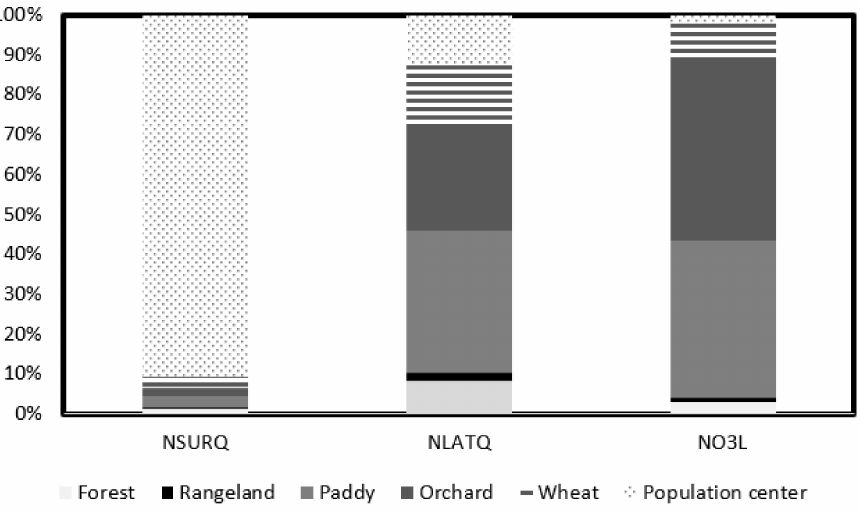
Figure 9. Various components related to nitrogen losses. NSURQ: NO 3 contributed by HRU in surface runoff to reach (kg N/ha), NLATQ: NO 3 contributed by hydrologic response unit (HRU) in lateral flow to the adjacent stream (kg N/ha), NO 3 L: NO 3 leached below the soil profile (kg